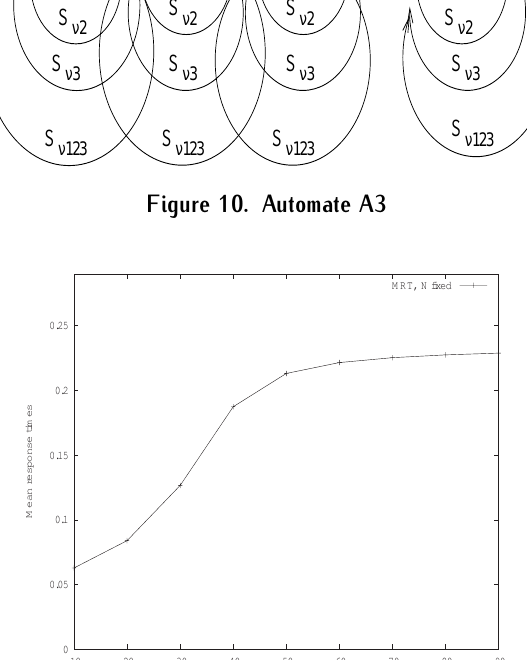
Figure 10. Automate A3